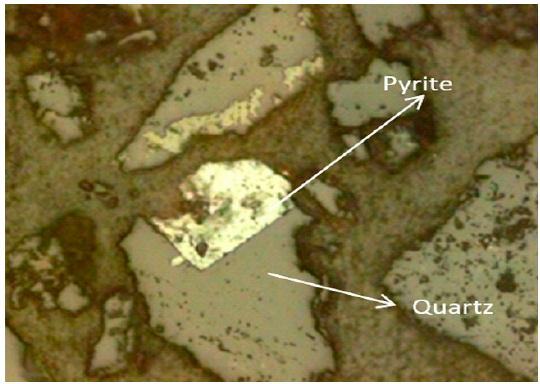
Figure 1. X-ray diffractogram showing the mineralization matrix of the Dos Carlos mine dumps of the State of Hidalgo, Mexico.